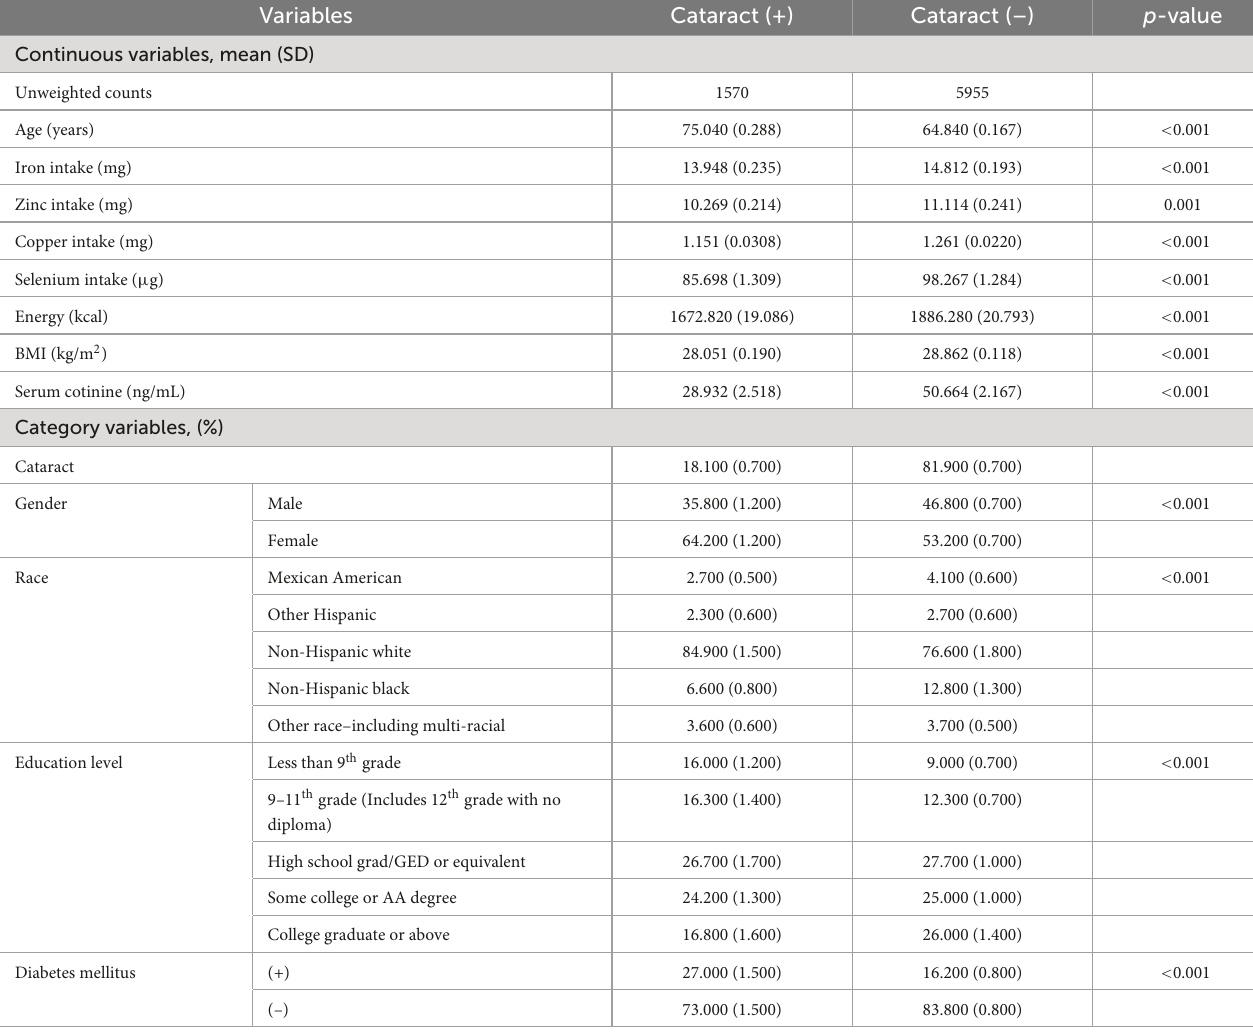
TABLE 1 Baseline information for the study sample.